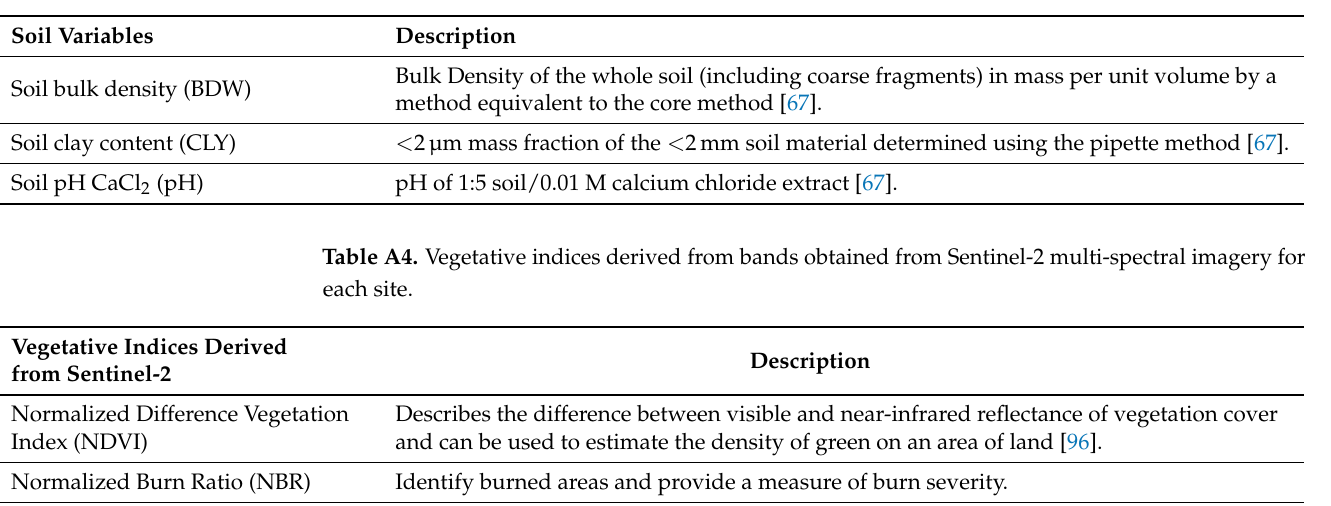
Table A3. Soil variables obtained from CSIRO Data Access Portal at a resolution of 3 × 3 arcseconds and re-sampled at resolution of 20m for each site.